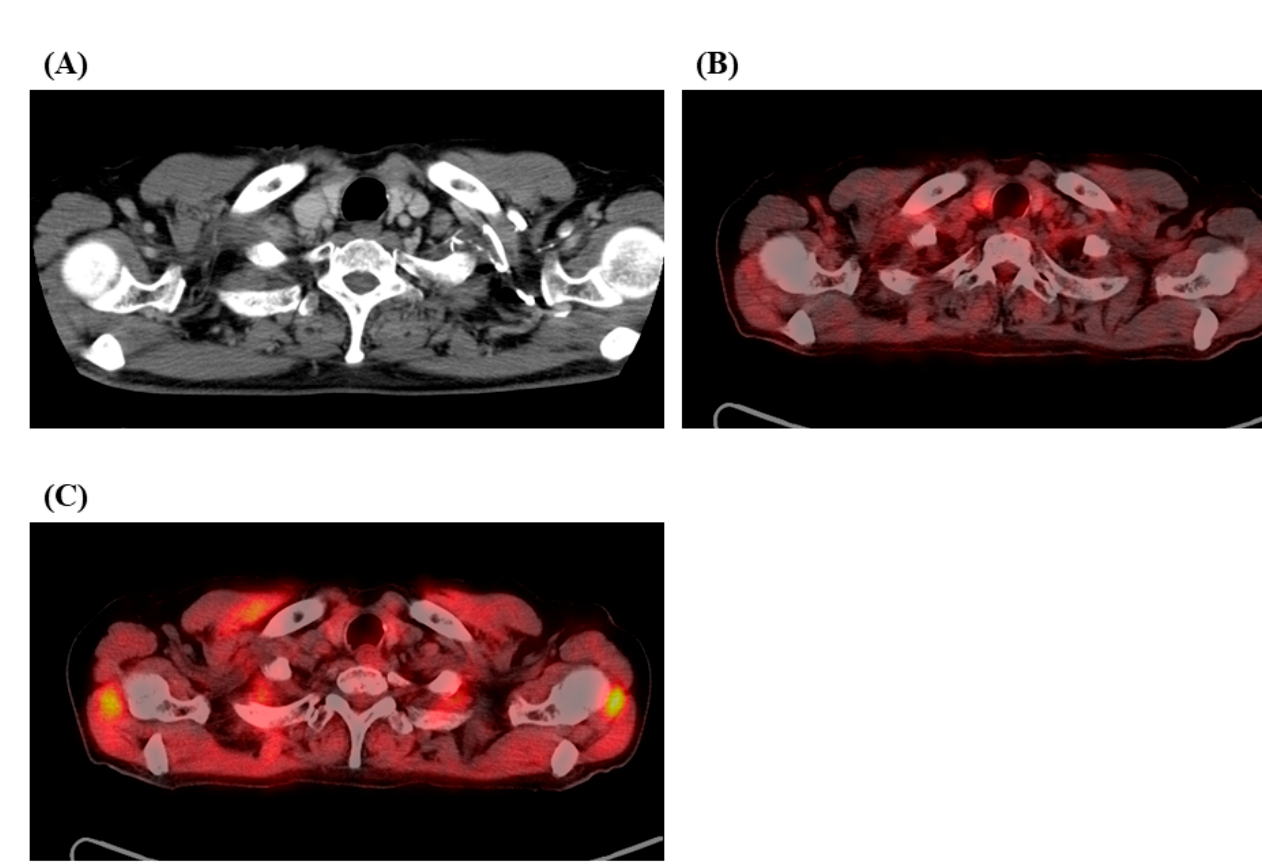
Figure 2. Contrast-enhanced CT after two cycles of induction therapy ( A ) with atezolizumab, bevacizumab, carboplatin, and paclitaxel (ABCP) demonstrated partial response (PR), and 18 F-fluorodeoxyglucose (FDG) positron emission tomog- raphy/CT after four cycles of induction therapy ( B ) showed metabolically PR with a maximum standardized uptake value of FDG decreasing to 1.5. FDG/PET after 11 cycles of continuation maintenance therapy ( C ) with atezolizumab and bevacizumab exhibited complete metabolic response without any FDG accumulation.